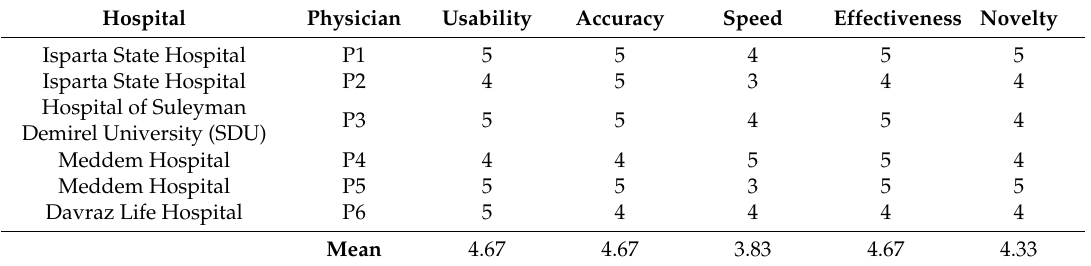
Table 16. Findings from the survey work done with the physicians using ANN–ALO for EEG